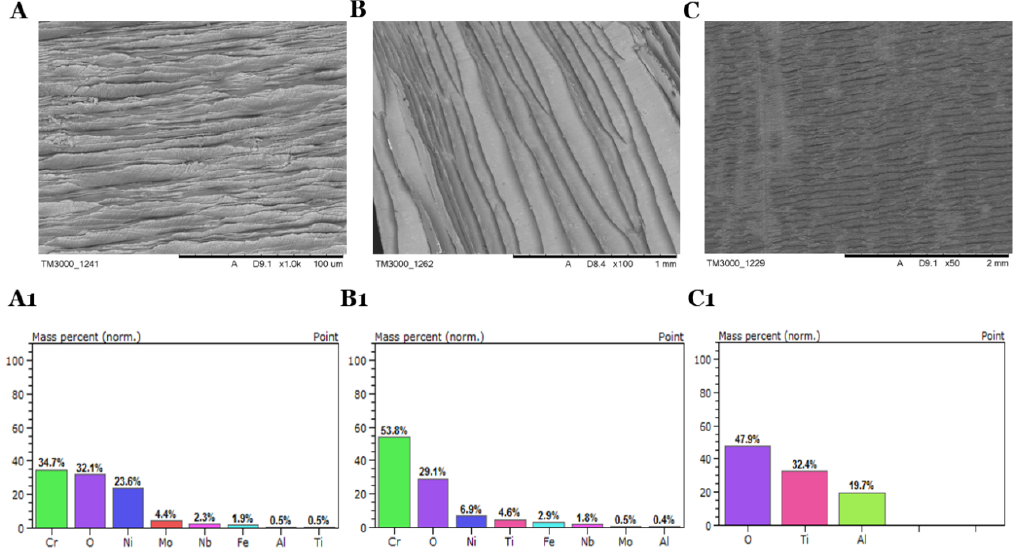
Figure 6. SEM-EDS photos after oil removal from Inconel 625 ( A , A1 ), Inconel 718 ( B , B1 ), Titanium Grade 5 ( C , C1 ) swarfs in a thermal process (900 °C) with the elemental composition of the surfaces.